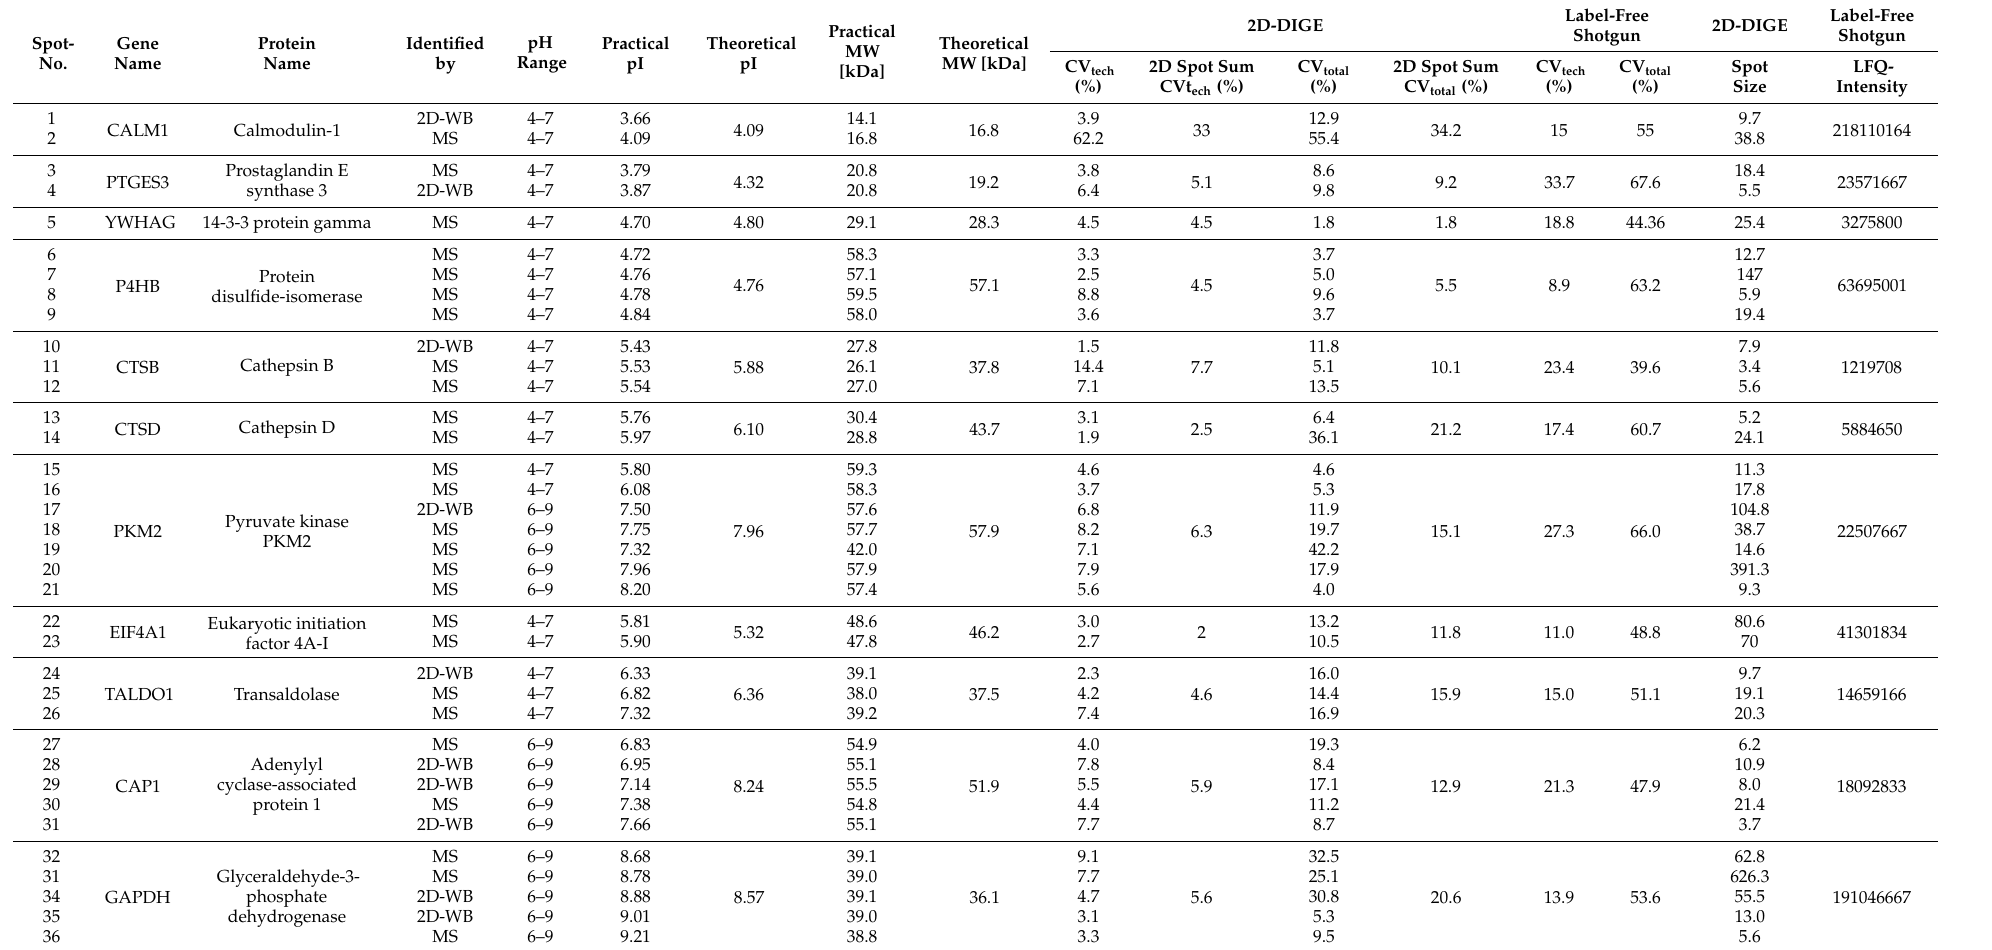
Table 1. Qualitative and Quantitative Proteoform to protein comparison of mutually identified entities by 2D-DIGE and shotgun. Spot-